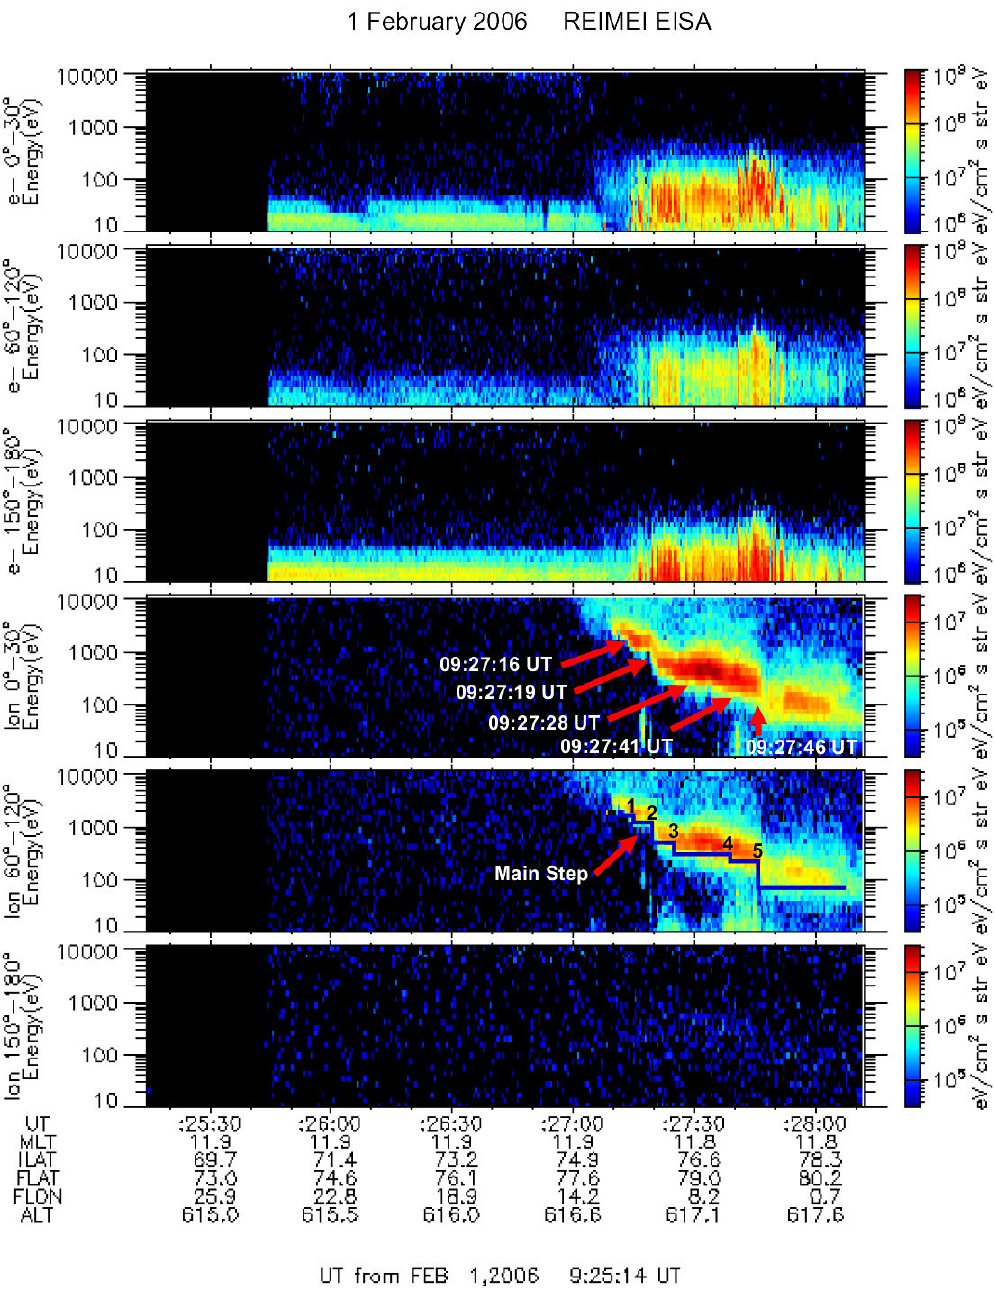
Fig. 2. In this REIMEI EISA plot, the 3 upper panels show the electron flux and energy versus time. The first from top is for pitch angles 0 ◦ –30 ◦ (down), the second for 60 ◦ –120 ◦ and the last for 150 ◦ –180 ◦ (up). The 3 lower panels display ion flux and energy correspondingly. The stepped ion-energy-dispersion is marked with red arrows and their respective start time. The largest transition is the 2nd step, which are marked as the main